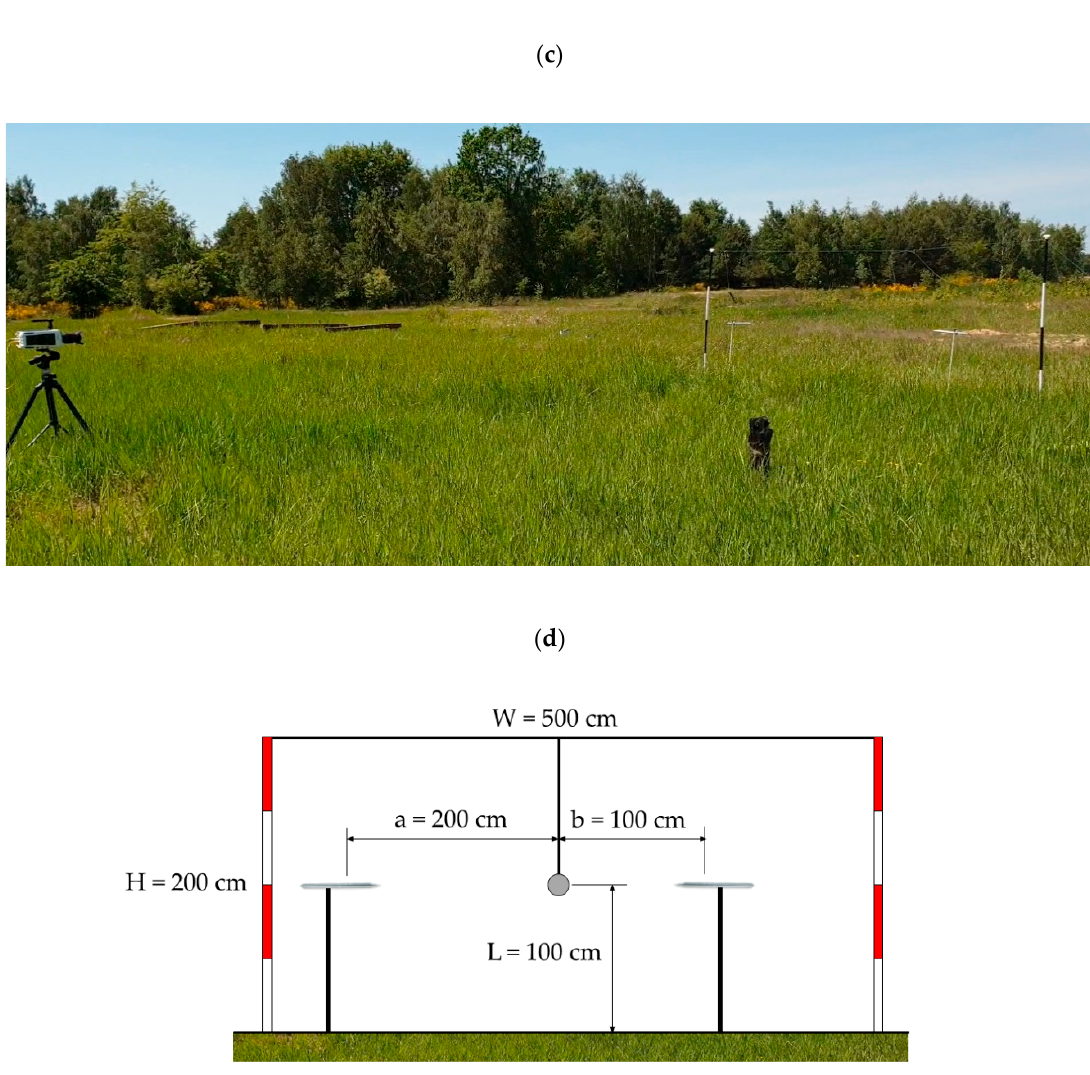
Figure 1. Test set up: ( a ) example of tested mixture of aluminium powder; ( b ) snapshot of the explosion; ( c ) overview of the explosion area; and ( d ) explosive devices’ mounting scheme.